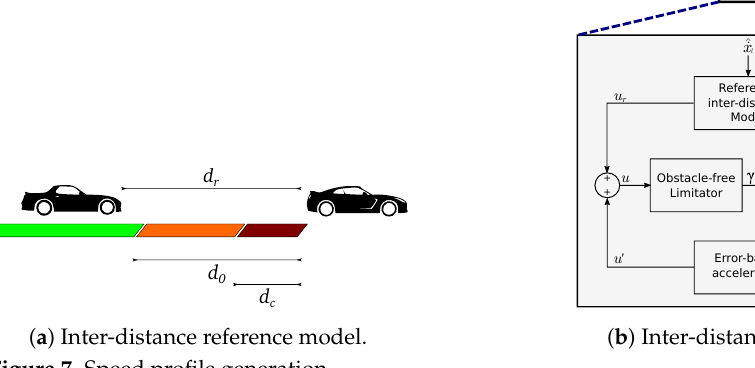
Figure 7. Speed profile